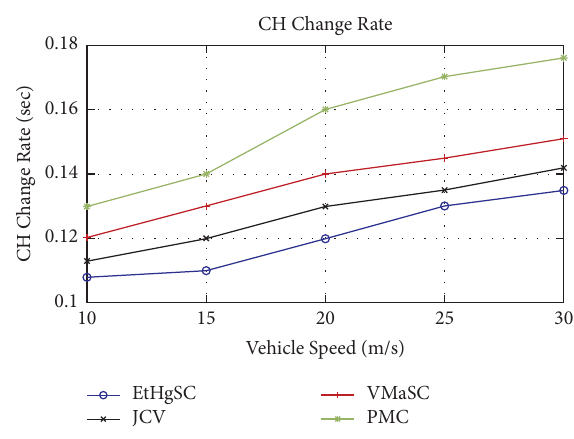
Figure 11: CH change rate at diferent